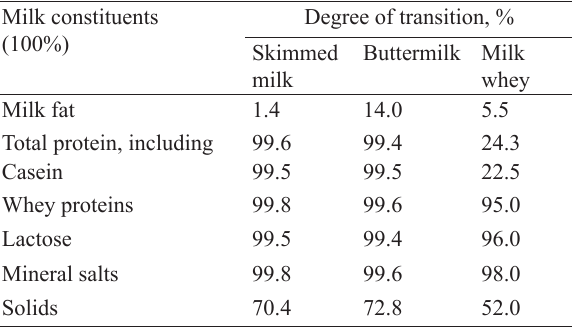
Table 2 Degree of transition of the main dairy constituents into the secondary dairy raw materials Milk constituents